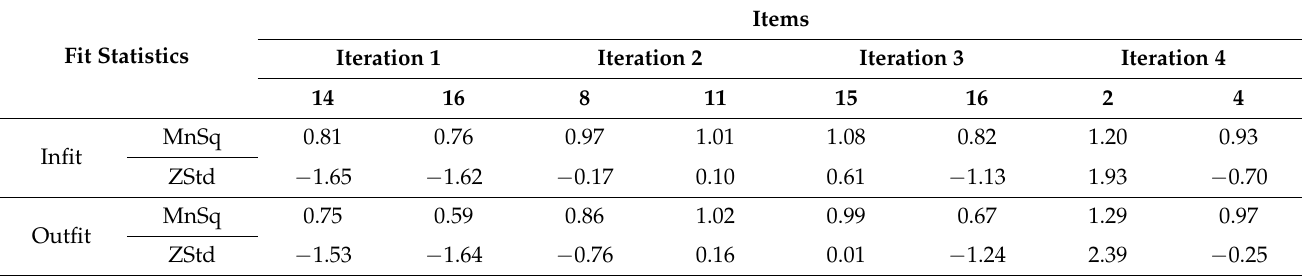
Table 1. Fit statistics for dependent